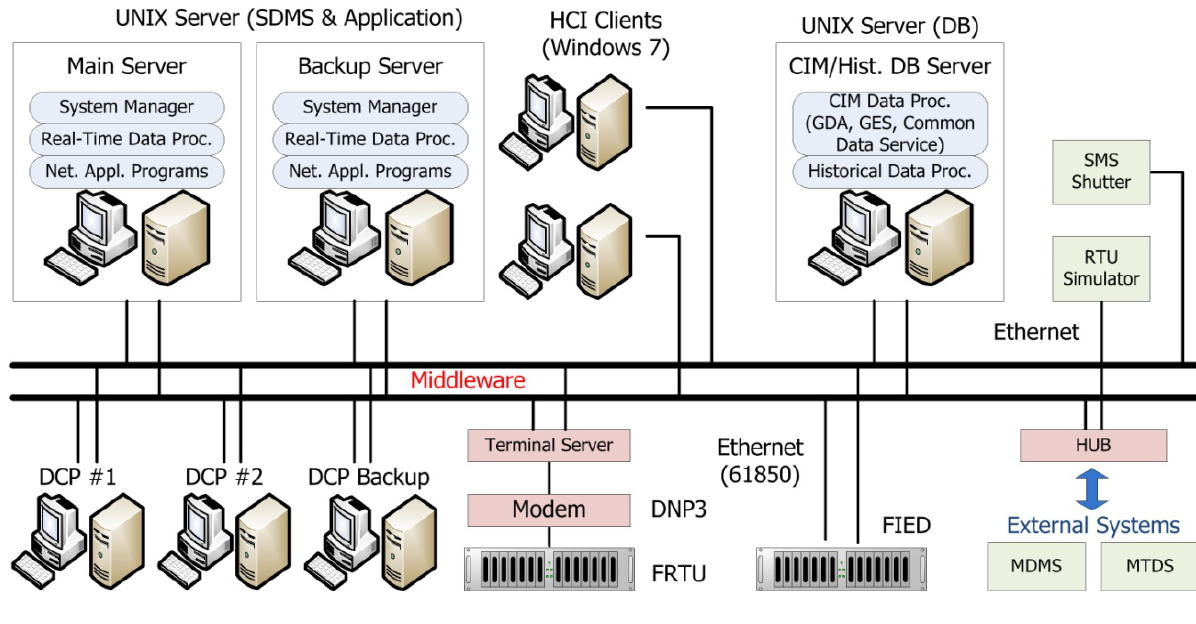
Figure 3. KSDMS platform architecture. DB: